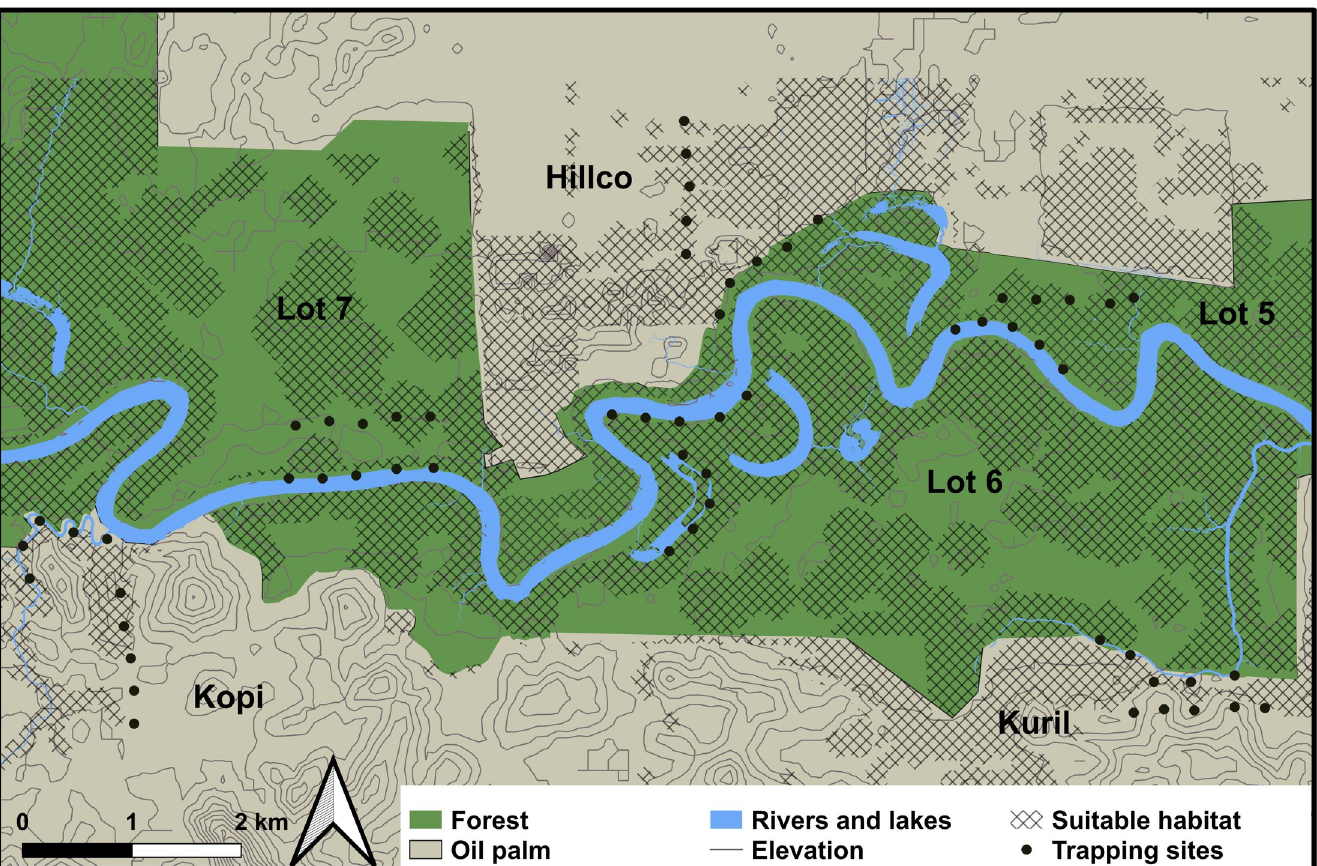
Fig 1. Distribution of trapping sites and areas covered during the study in the Lower Kinabatangan Wildlife Sanctuary and surrounding plantations.